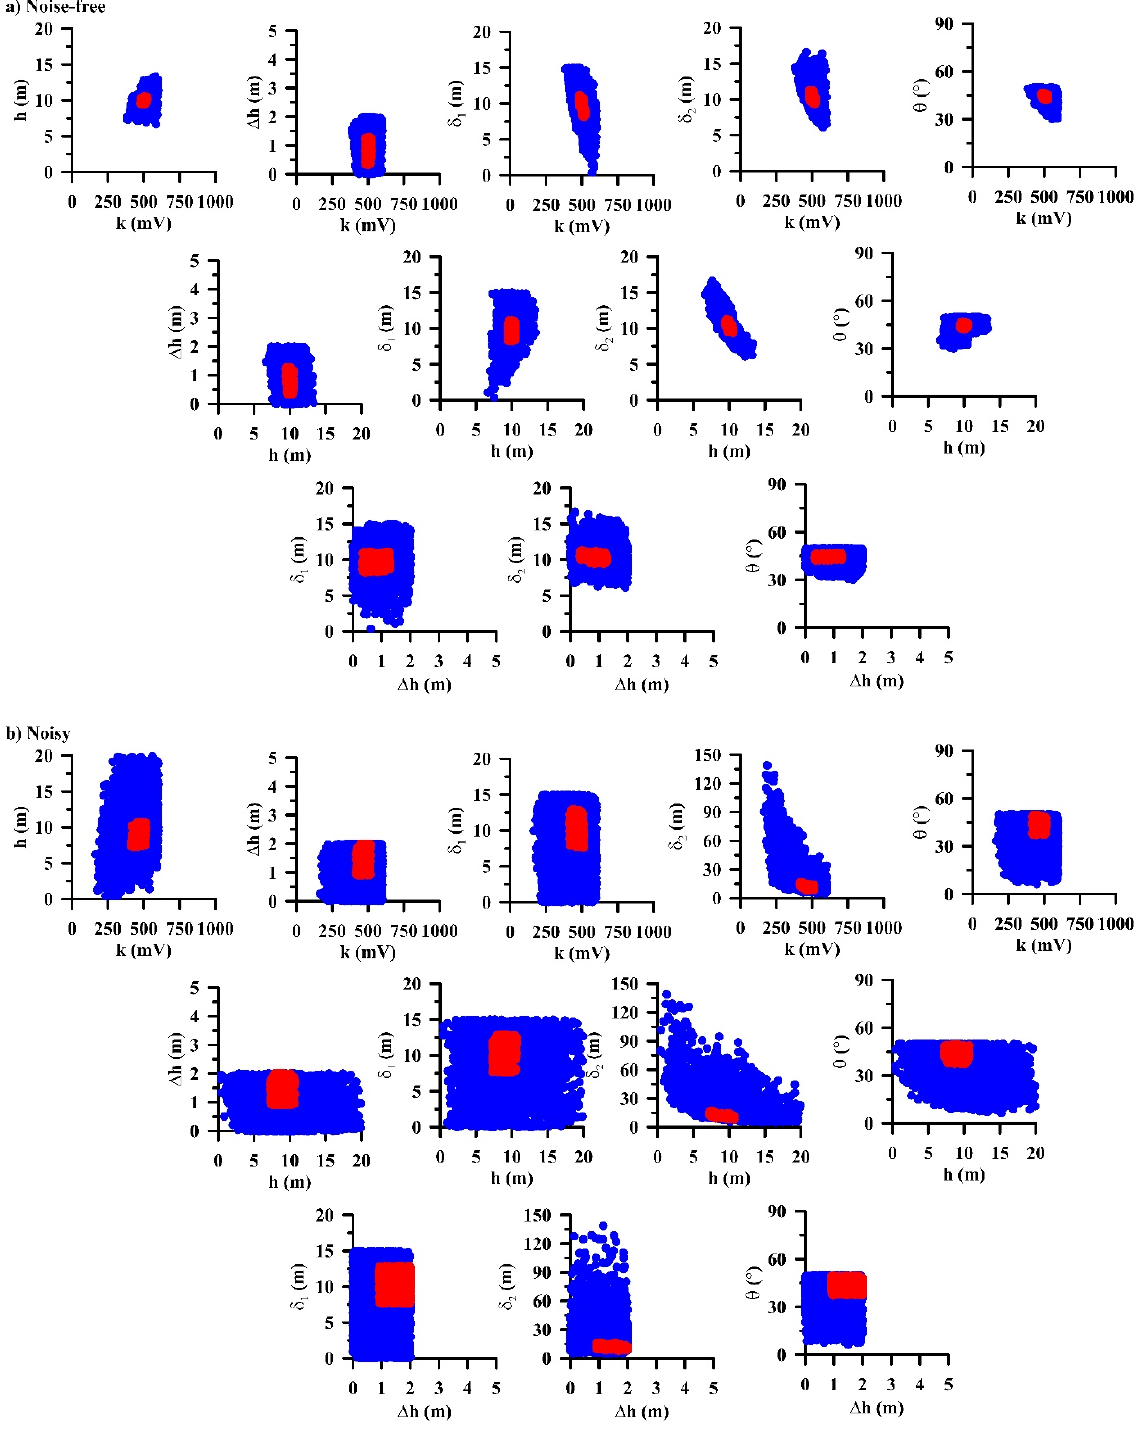
Figure 8. 2D cross-plot for layer/bed Model 1: ( a ) Noise-free, and ( b ) Noisy synthetic data. Since the cross-plots from the study show that the three parameters Δ h, δ 1 , and δ 2 , depict uncertainty in the interpretation, hence, a 3D cross-plot was also prepared for this investigation (Figure 9). It was found that these three parameters ( Δ h, δ 1 , δ 2 ) show a di- verse solution (yellow) with similar models with smaller errors. The concluding mean model parameter was observed within the well-defined uncertainty margins in the high PDF (Red) region. Figure 9a,b demonstrate the 3D scatter plot for noise-free and noise- corrupted data.